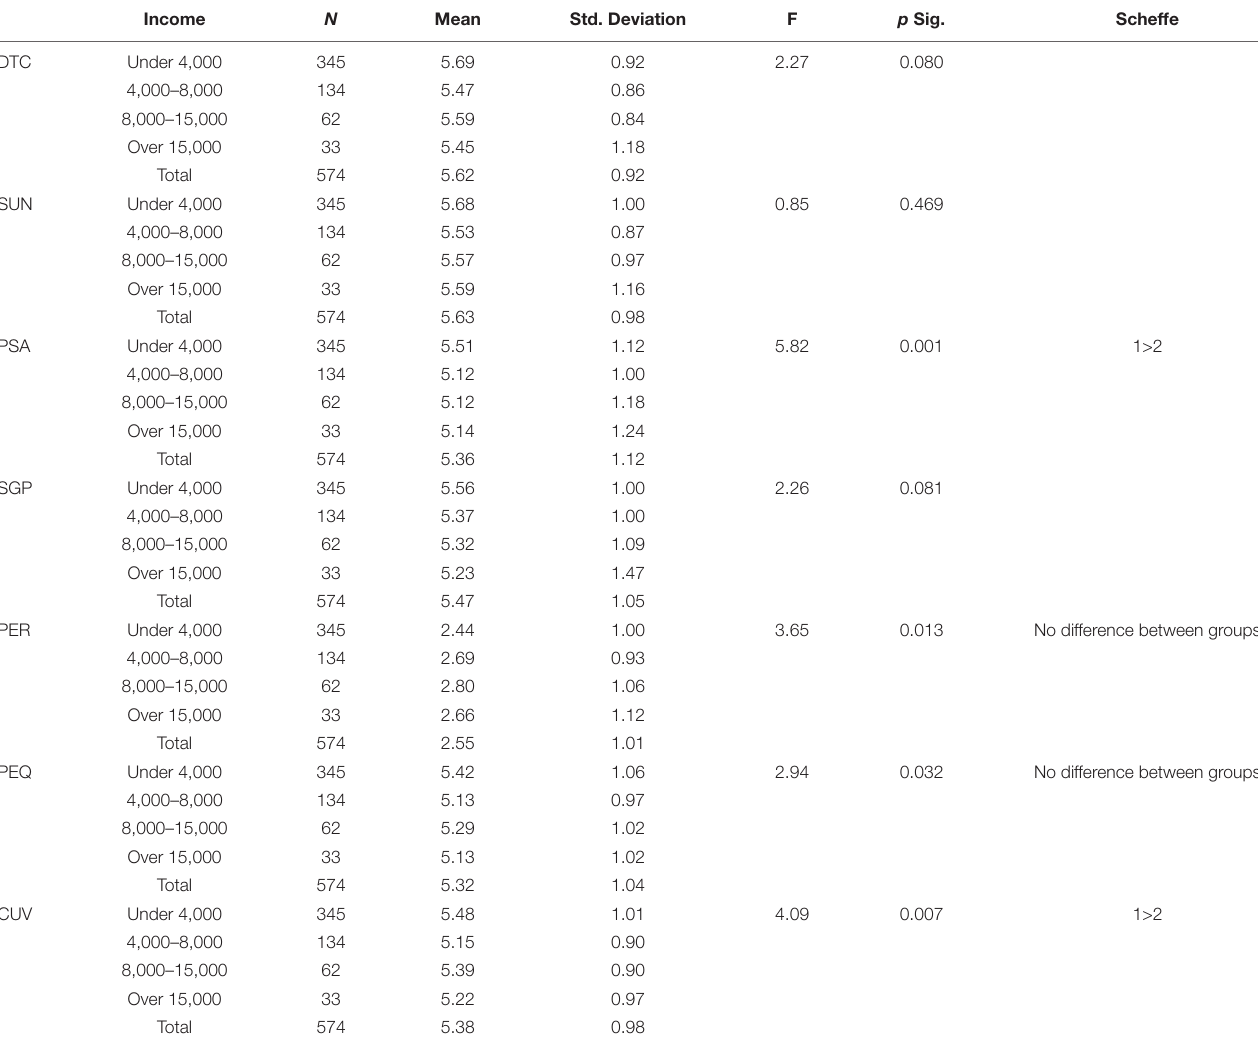
TABLE 11 | Analysis of variance by